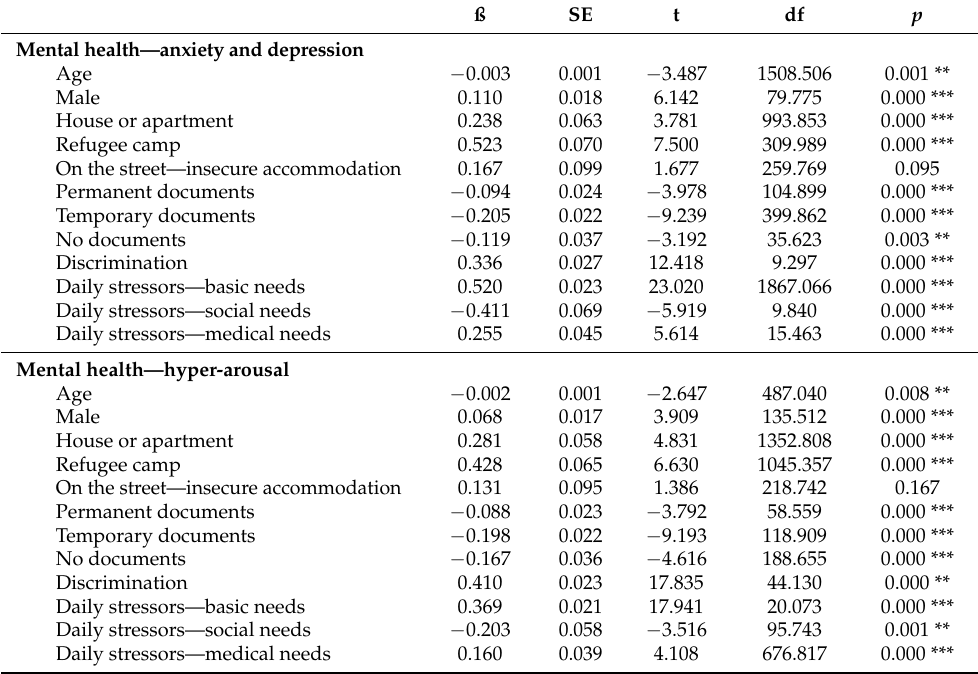
Table 7. Structural equation